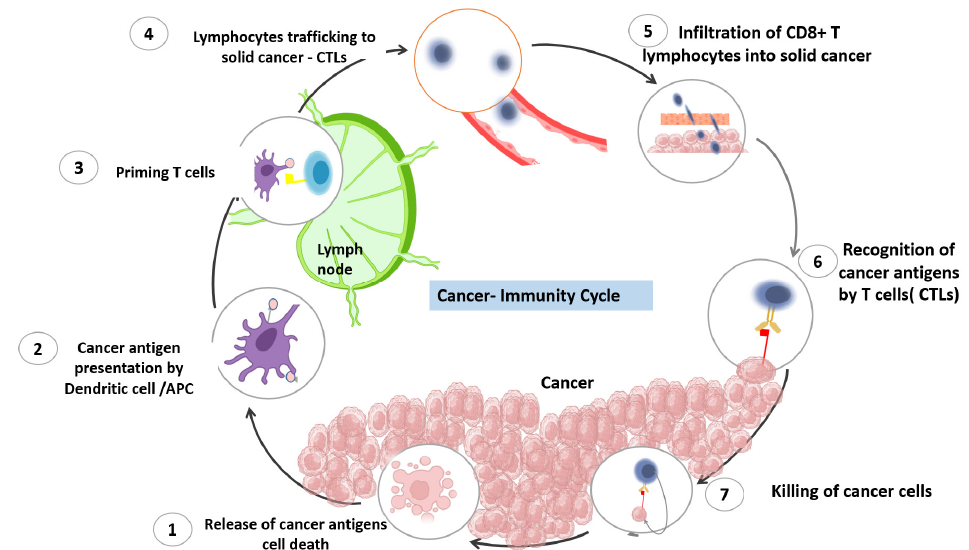
Figure 1. The cancer-immunity cycle. The cancer-immunity cycle is a series of steps through which the immune system passes in order to recognize and attack cancer cells. The cycle includes seven stages, starting with the release of cancer-cell antigens and ending with the destruction of cancer cells by T cells. The first stage involves the release of antigens from dying cancer cells. These antigens are then taken up by dendritic cells, which present them to T cells in the lymph nodes. In the second stage, activated T cells migrate to the tumor site and infiltrate the tumor. The third stage involves recognition of cancer cells by T cells, and the fourth stage involves the activation of T cells to recognize and kill cancer cells. In the fifth stage, T cells work to penetrate the tumor and release cytokines that recruit immune cells to the tumor site. In the sixth stage, immune cells, including macrophages and dendritic cells, infiltrate the tumor and destroy cancer cells. Finally, in the seventh stage, the immune system remembers the cancer cells, creating a lasting immune response that can protect against future cancer development.